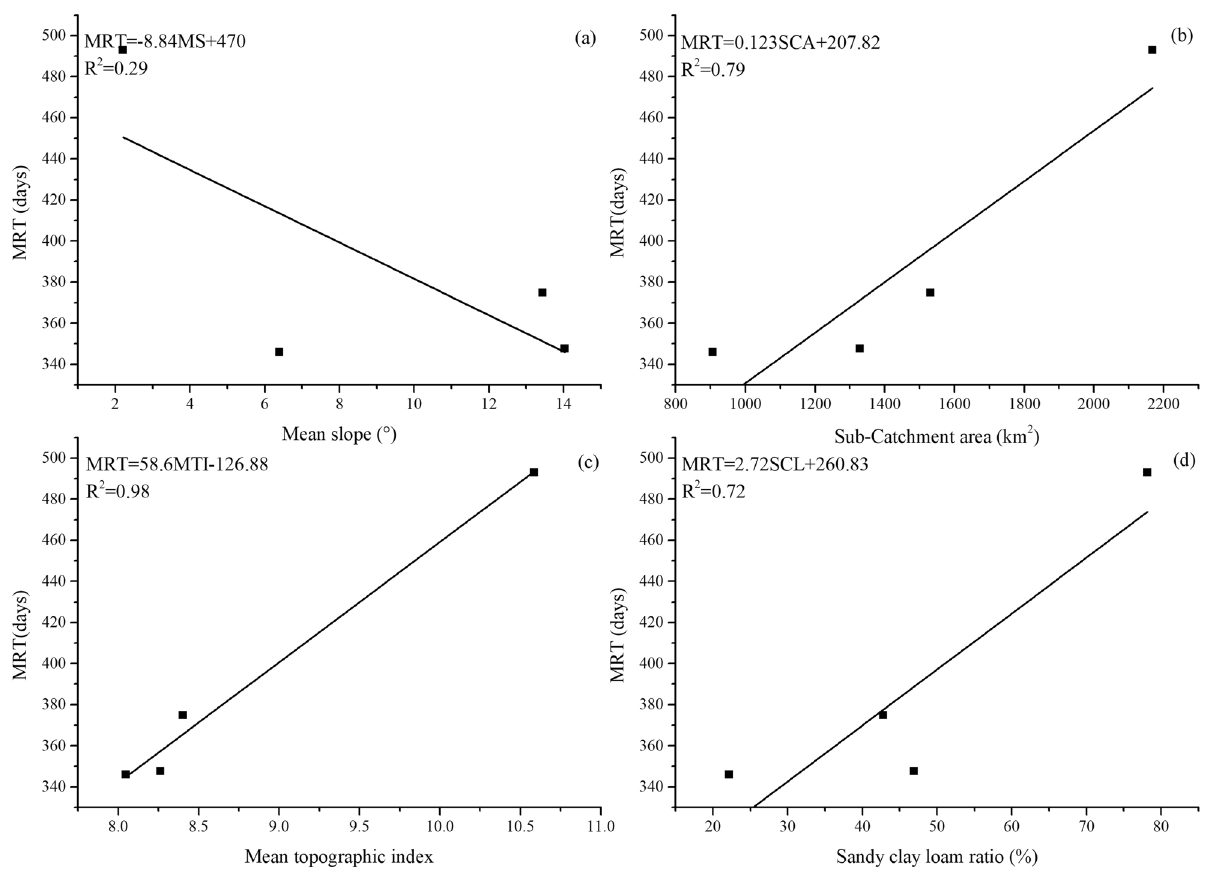
Figure 5. Relationships between mean slope ( a ), sub-catchment area ( b ), mean topographic index ( c ), sandy clay loam ratio ( d ) and